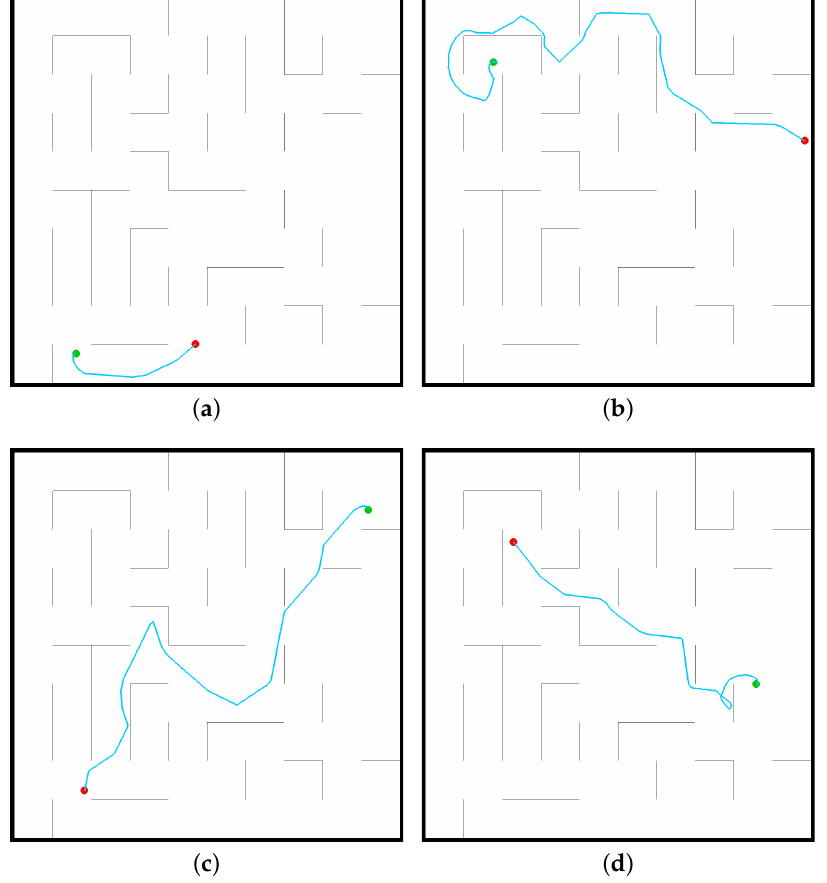
Figure 7. Successful cases using the DQN algorithm to solve the mobile robot navigation task by analysis in RoNAP: ( a ) DQN_case1, ( b ) DQN_case2, ( c ) DQN_case3, ( d )